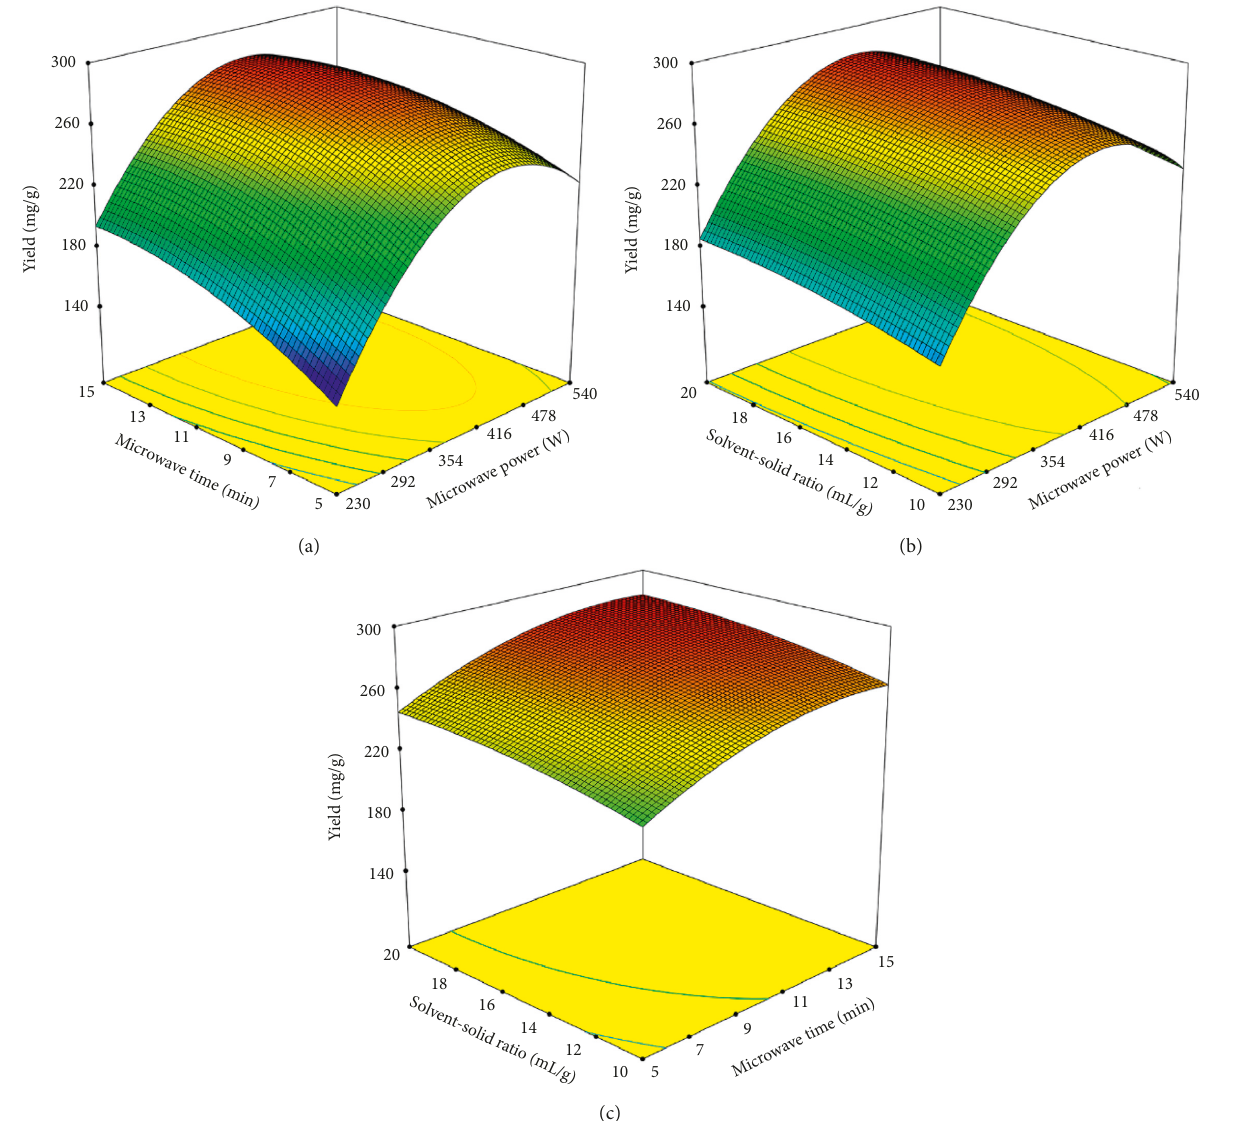
Figure 2: Response surface and contour plots for the interaction influences of parameters on the saponins extraction yield. (a) Interactions of microwave time and microwave power (1g samples sieved with 80–100 mesh size particles were mixed with 15mL 40% (v/v) of ethanol water solution and soaked for 3h then extracted by MAE). (b) Solvent-solid ratio and microwave power (1 g sample sieved with 80–100 mesh size particles was mixed with 40% (v/v) of ethanol water solution and soaked for 3h then extracted for 10min by MAE). (c) Solvent-solid ratio and microwave time (1g sample sieved with 80–100 mesh size particles was mixed with 40% (v/v) of ethanol water solution and soaked for 3h then extracted with 425W by